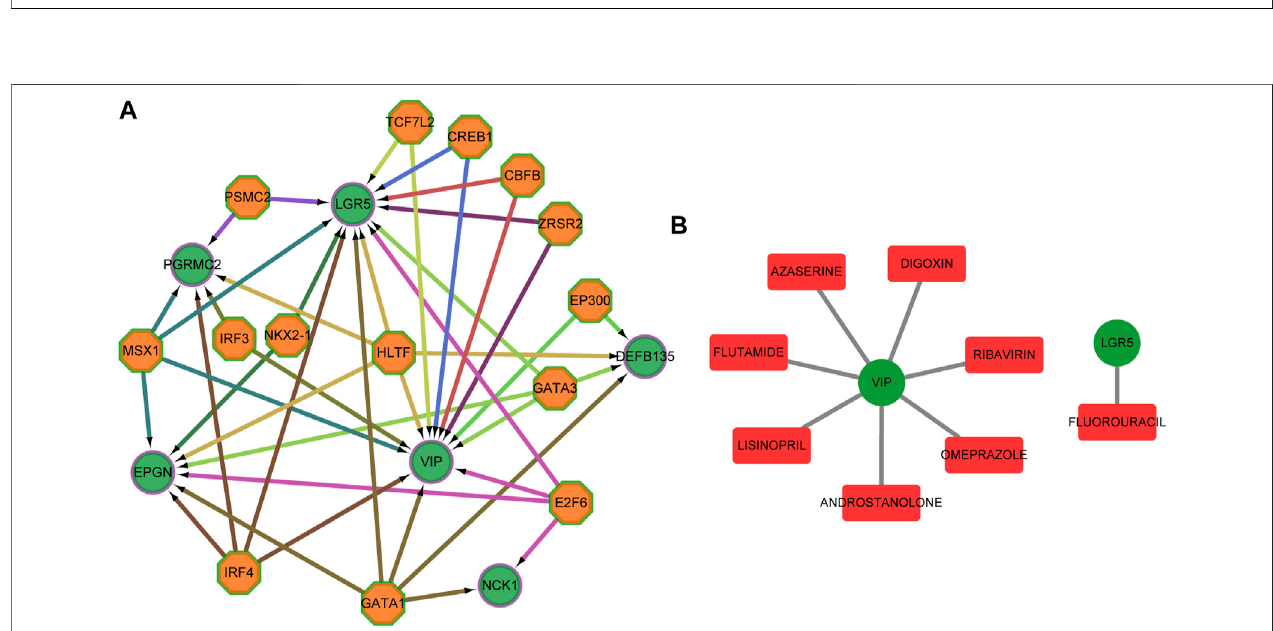
FIGURE 10 | Transcription factors and target drugs analysis. (A) Regulatory network of the predicted transcription factors and the target genes. (B) Drug-gene network using gene-centric fashions. Green circles indicate target genes, orange octagons indicate predictive transcription factors, and red quadrilateral indicate predictive